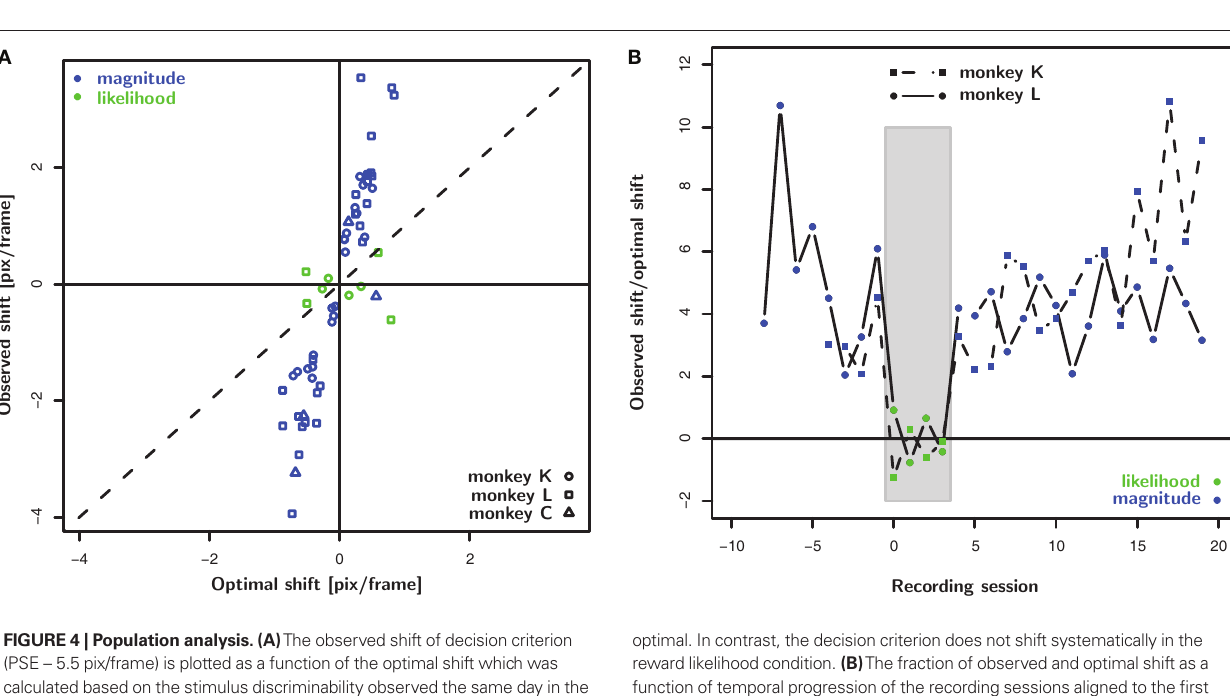
optimal. In contrast, the decision criterion does not shift systematically in the reward likelihood condition. (B) The fraction of observed and optimal shift as a function of temporal progression of the recording sessions aligned to the first reward likelihood session. For both monkeys we observed overcompensation in the reward magnitude condition prior to and after the sessions which failed to find any compensation for the reward likelihood